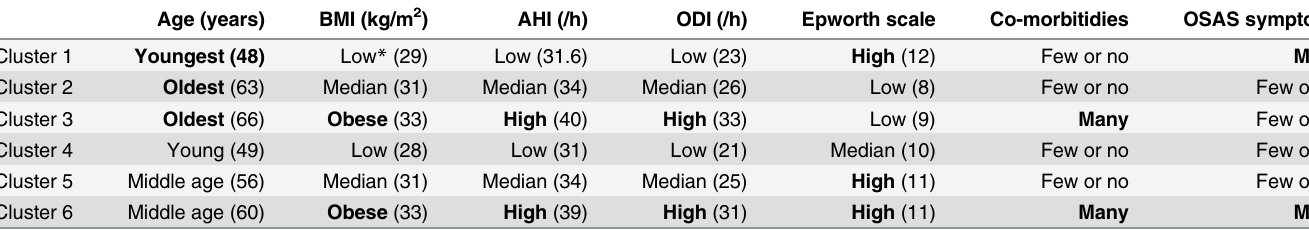
Table 4. Summary of main features of the different clusters. In bracket: median values for